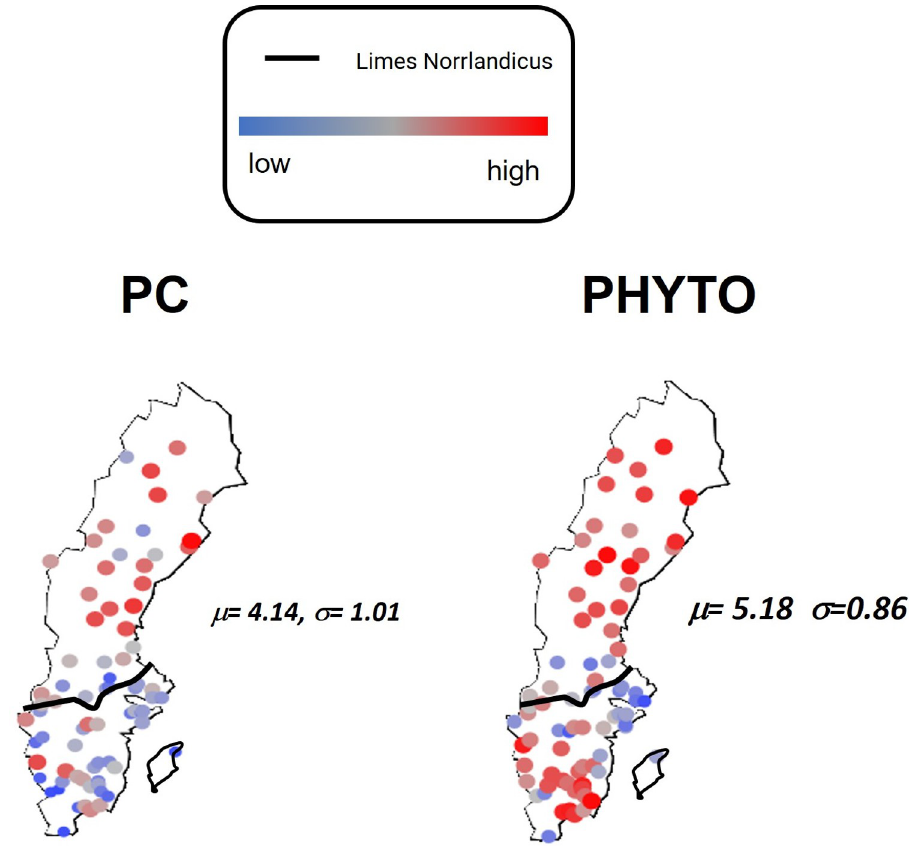
Fig 2. GIS plots of the 1996 FI results computed from the physicochemical (PC) and phytoplankton (PHYTO) data. A blue to red color scheme and marker size gradient are used to distinguish low to high FI values over the